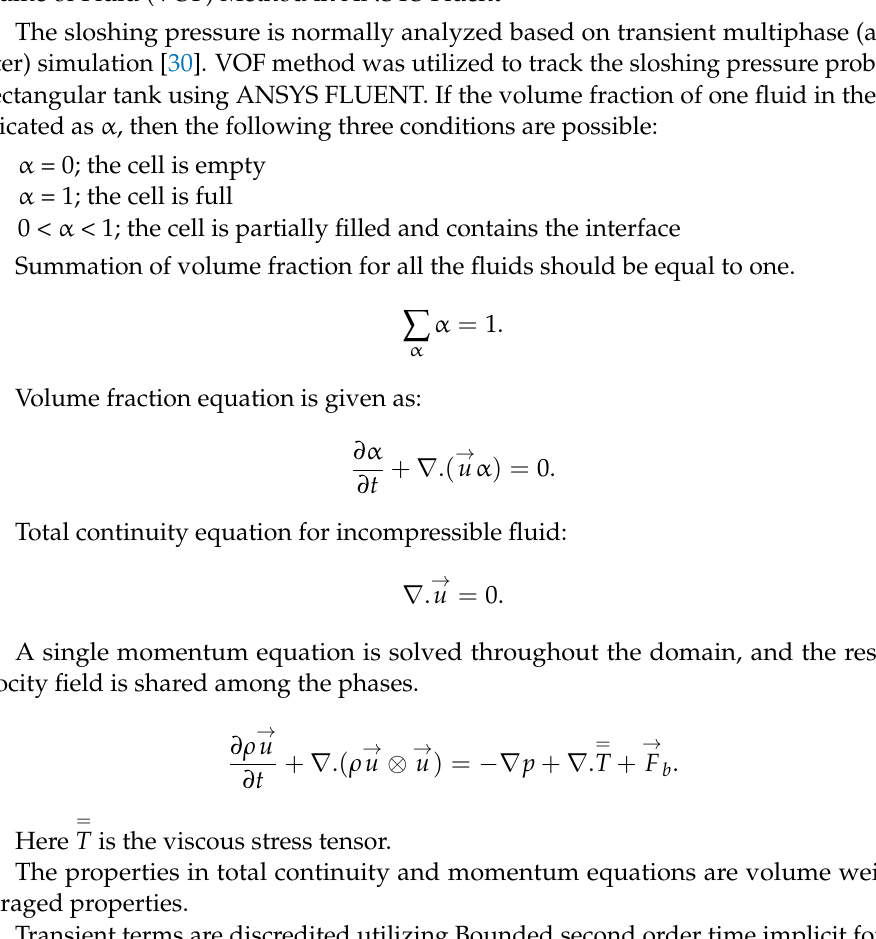
Figure 3. Schematic diagram showing: ( a ) dimensions of perforated baffle; ( b ) isometric view of the rectangular tank with perforated baffle in ANSYS SpaceClaim.